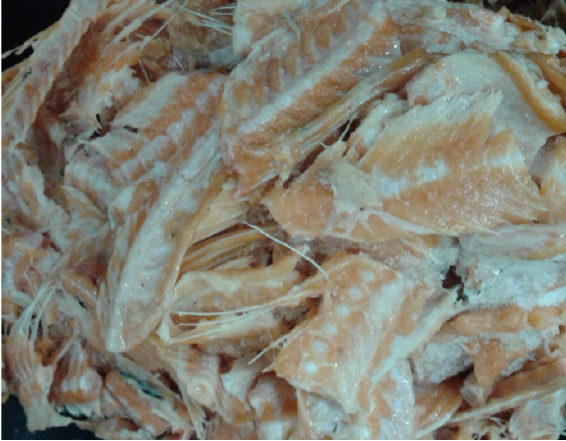
Figure 2: Atlantic salmon backbones devoid of heads and fins (raw material for